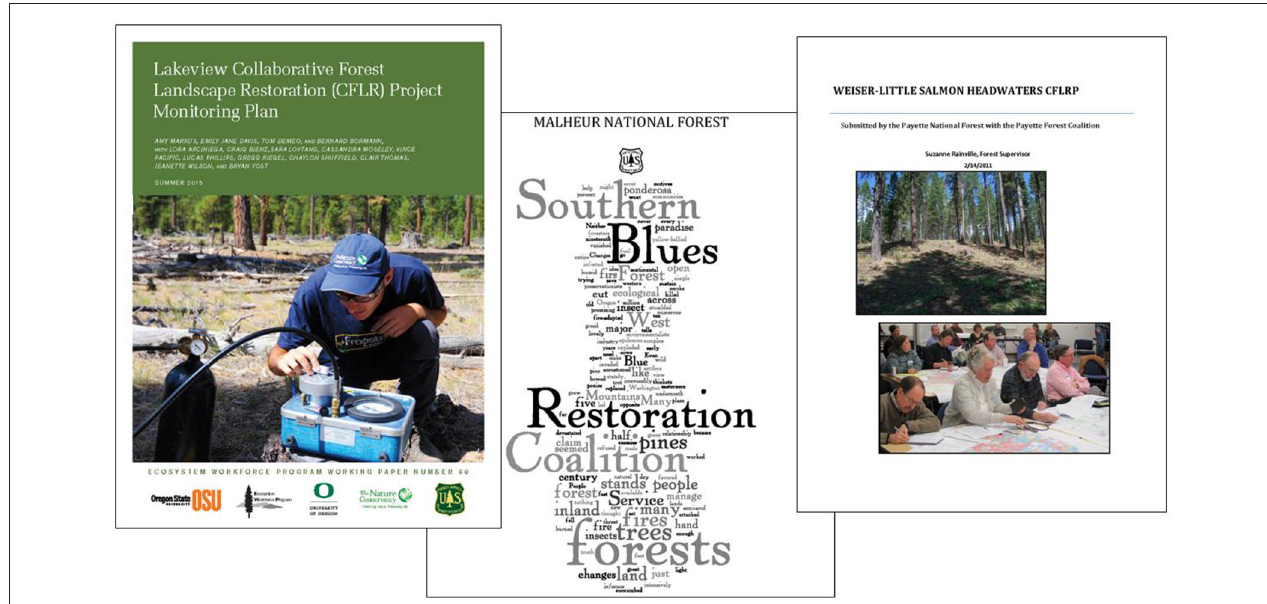
FIGURE 6 | Collaborative wildland governance through CLFRP. The focus of CFLRP collaboratives is developing a shared concept of desired conditions, including social, economic, and ecological attributes of a landscape that management strives to achieve (e.g., reduced risk of severe fires, improved wildlife habitat, maintenance of large old trees). Science legitimacy of the process is attained by engaging scientists and respected experts to interpret the research, while maintaining independence from the decision-making process ( Urgenson et al., 2017). Research conducted on woodpecker populations of the Interior Northwestern U.S. is an example of targeted experimental research in conjunction with the required monitoring for CFLRPs. The research has been conducted for the duration (8–10 years) of CFLRPs on three National Forests (Payette, Fremont-Winema, and Malheur National Forests) across two Forest Service Regions (4 and 6) in dry mixed coniferous forests. Collaborative stakeholders comprise local community organizations, state governments, and federal agencies, all with an interest in public land management. Each collaborative invited scientists from state and federal agencies, and universities to participate in developing and implementing monitoring plans for focal plant and animal species within the CFLRP project areas. In the case of these 3 CFLRPs, all chose to include monitoring of woodpecker populations in relation to forest management activities (See Figure 5 ). The required monitoring allowed rigorous experimental design (Before, After, Control, Impact [BACI]) to determine effectiveness of silvicultural, prescribed fire, and post-wildfire management activities to meet desired conditions and wildlife habitat goals. The research conducted as part of the required monitoring on these CFLRPs, and on projects supported by similar collaboratives, has resulted in a GIS decision-support tool for land management planning (see Figure 5 ; Latif et al.,